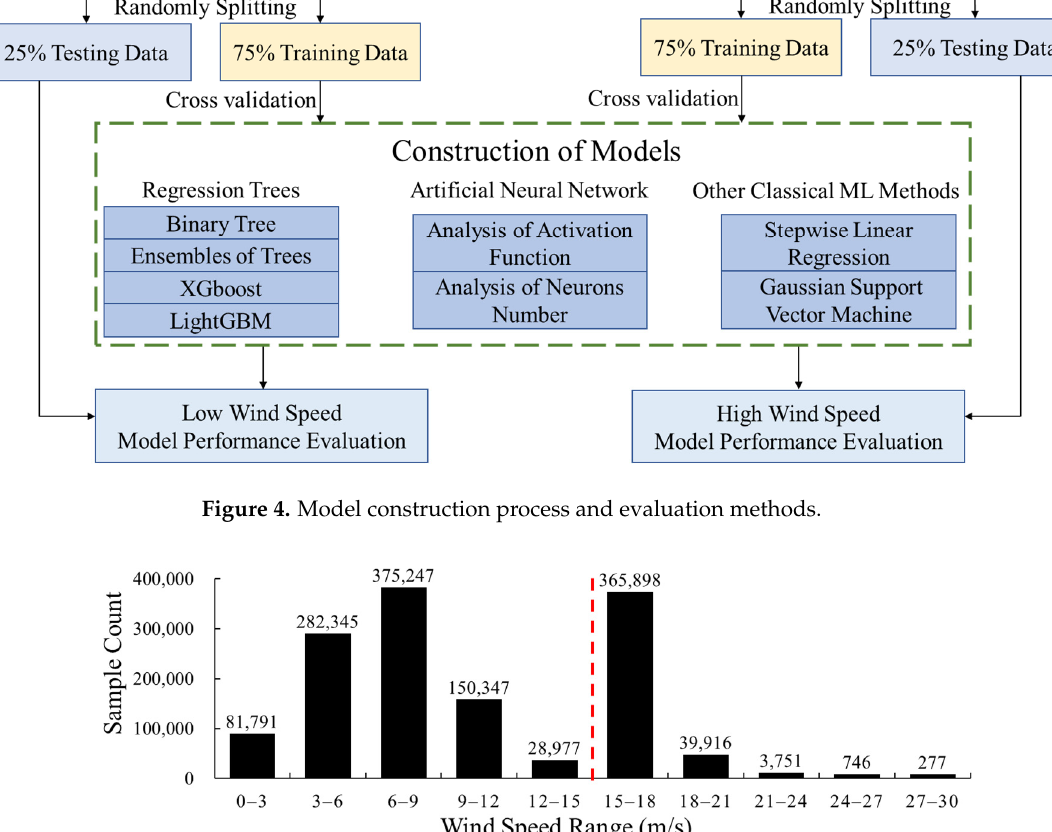
Figure 5. Wind speed distribution histogram. The red dotted line divides the dataset into the low wind speed dataset and the high wind speed dataset.